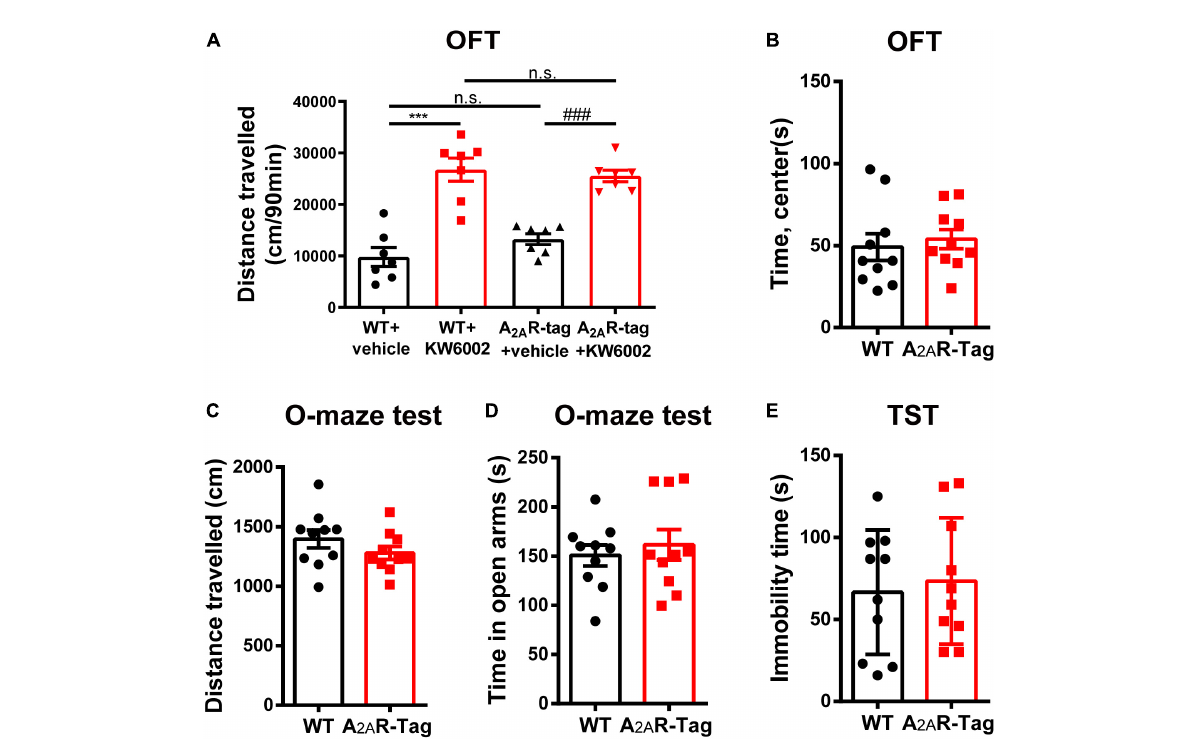
FIGURE2 Adenosine A 2 A receptor (A 2A R)-tag mice showed no alternation in locomotor and mood tests. (A) After the intraperitoneal administration of KW6002 (5 mg/kg) or vehicle (DMSO + castor oil), mice were subjected to the open field test (OFT) for 90 min. The distances traveled by A 2A R-tag mice or their wild-type littermates were significantly increased after KW6002 infusion, however, no difference in locomotor activity was observed between the two groups. Data are mean ± SEM (each dot represents one mouse, two-way ANOVA; interaction P > 0.05, KW6002; P < 0.0001; *** P < 0.0001, ### P < 0.0001, n.s. no significant). (B) Compared to the wild-type littermates, A 2A R-tag mice showed no alternation of time spent in the center of open field. (C,D) Compared to the wild-type littermates, A 2A R-tag mice displayed similar locomotion activity in elevated zero maze and spent a similar amount of time in the open arms. (E) A 2A R-tag mice exhibited similar immobility time in the tail-suspension test (TST) compared with control animals. Data are mean ± SEM (each dot represents one mouse, unpaired Student’s t